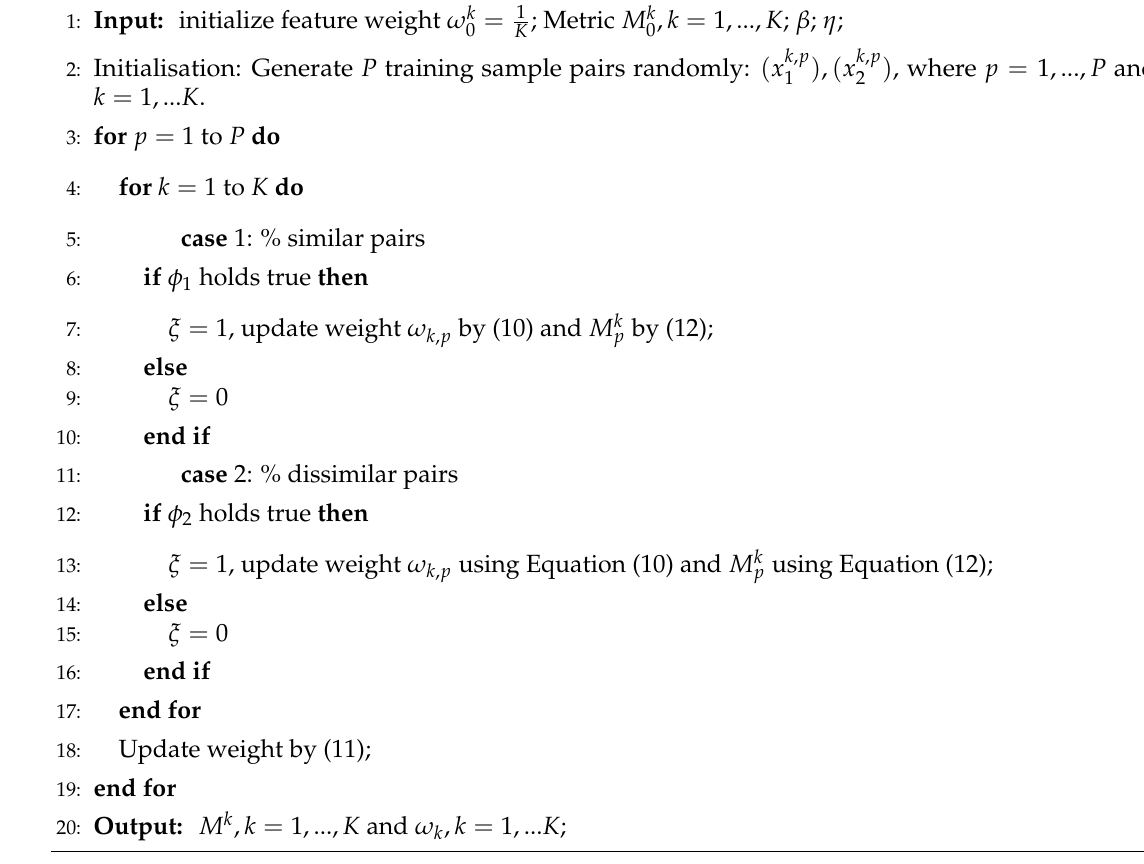
Algorithm 1 Online metric